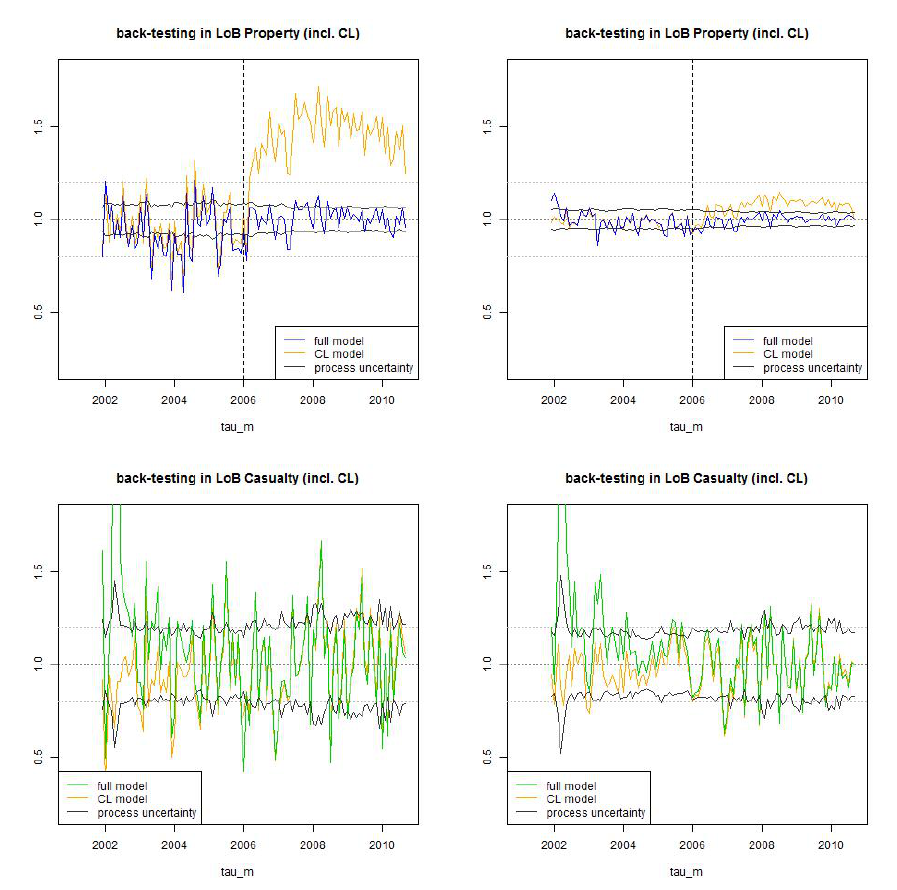
Figure 16. Back-test LoB Property (top) and LoB Casualty (bottom): we compare the (non-stationary) estimate χ i , j (blue/green) to the (stationary) chain-ladder estimate χ CL and (rhs) time lag j = 1. The black line shows the process uncertainty confidence bounds of 2 (relative) standard deviations ς i , j